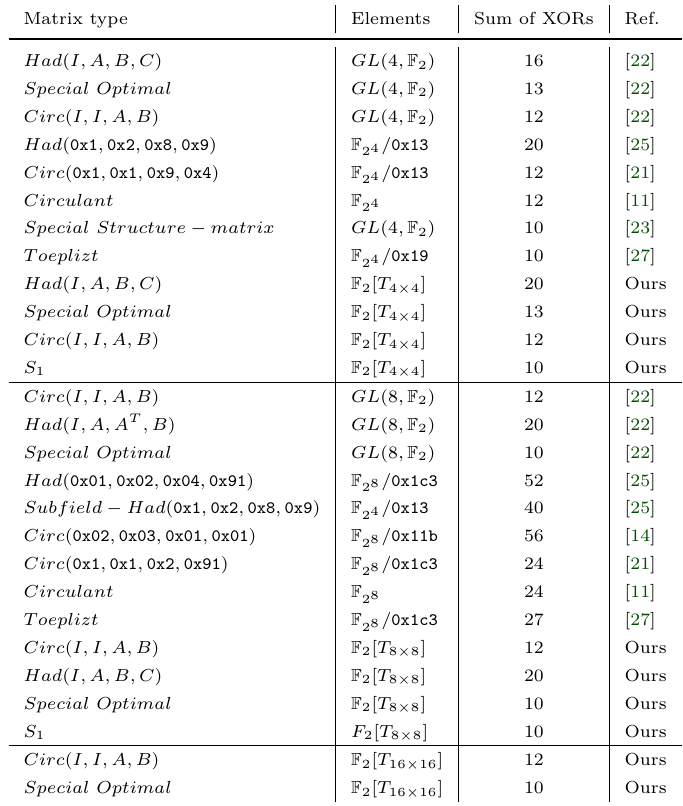
Table 4: Comparisons with previous constructions of MDS